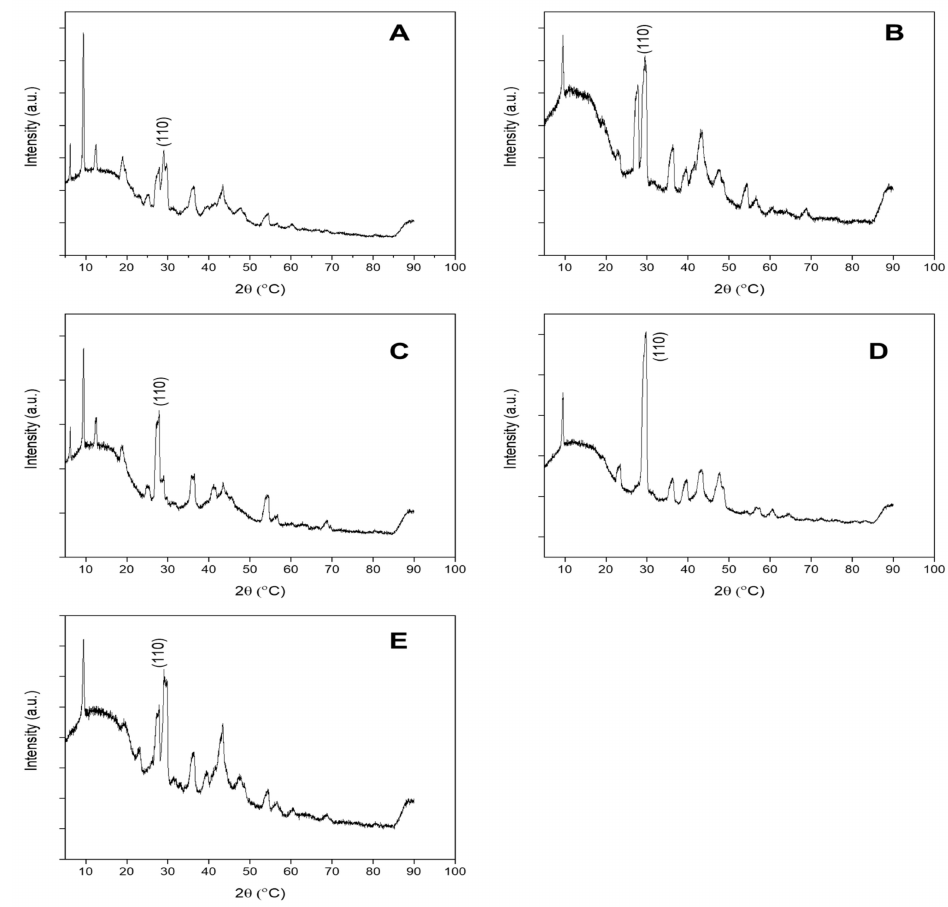
Figure 10. The XRD patterns of PA1 ( A ), PA2 ( B ), PA3 ( C ), PA4 ( D ), and PA5 ( E